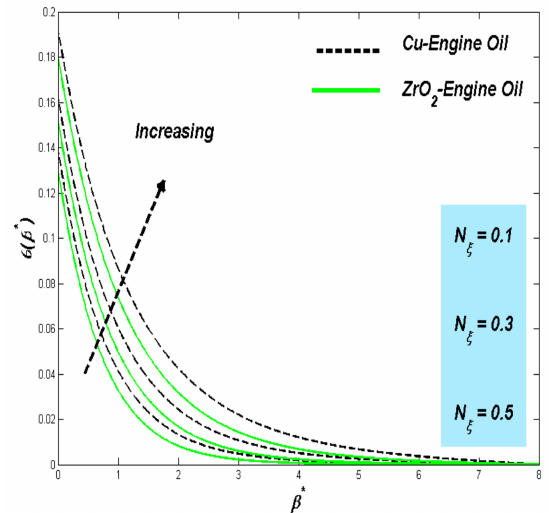
Figure 17. Temperature profile change with N ξ